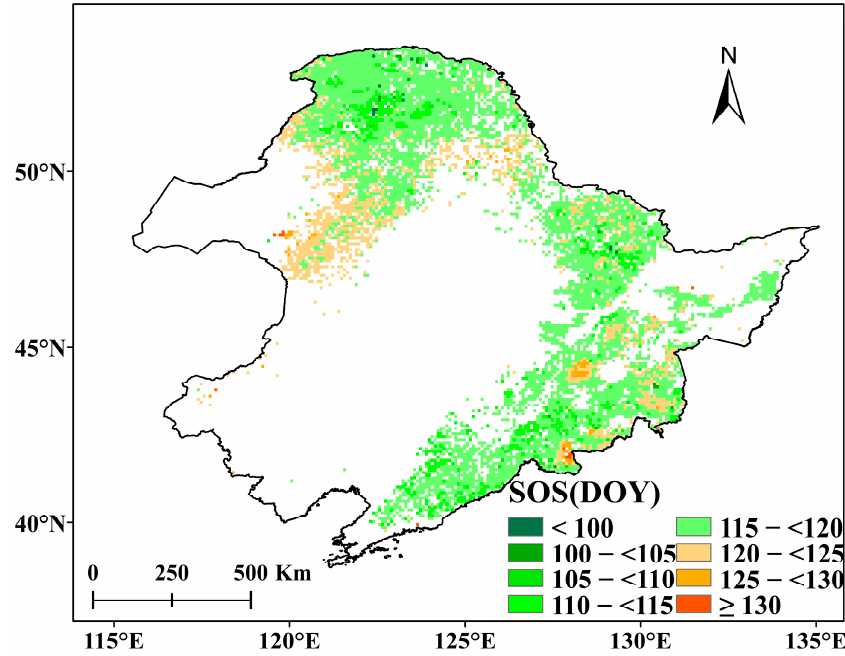
Figure 2. Spatial pattern of long-term average SOS of forests in Northeast China.